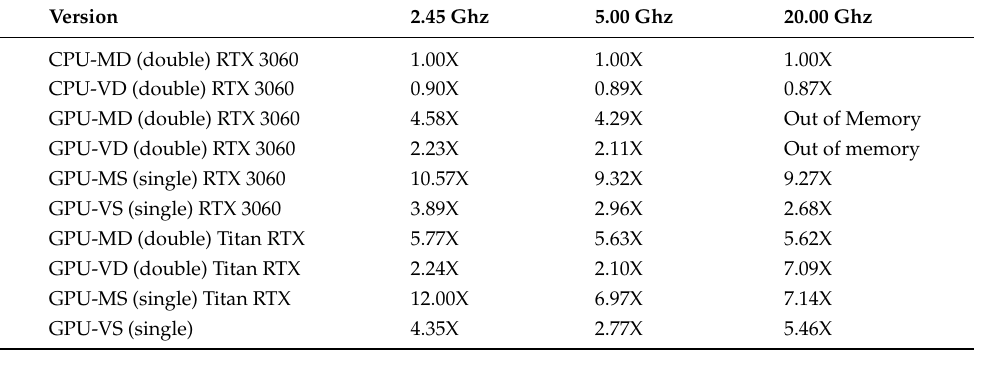
Table 13. Speed-up factors calculated using as a base the utilized execution time by CPU-MD, for the parabolic propagation.